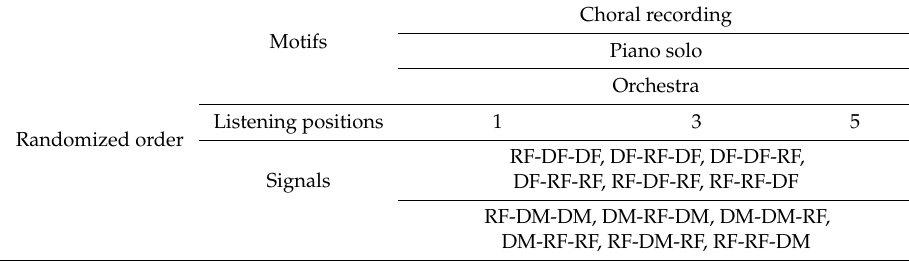
Table 2. Listening test scheme. Three different music samples played for three listening positions. Samples “RF” are compared with samples “DF” and “DM”, which correspond to the reflective and diffusive condition of the lateral wall, respectively. The order of presentation of the samples has been fully randomized: motif and listening position. Six (3!) permutations of RF and DF or DM order could occur within one